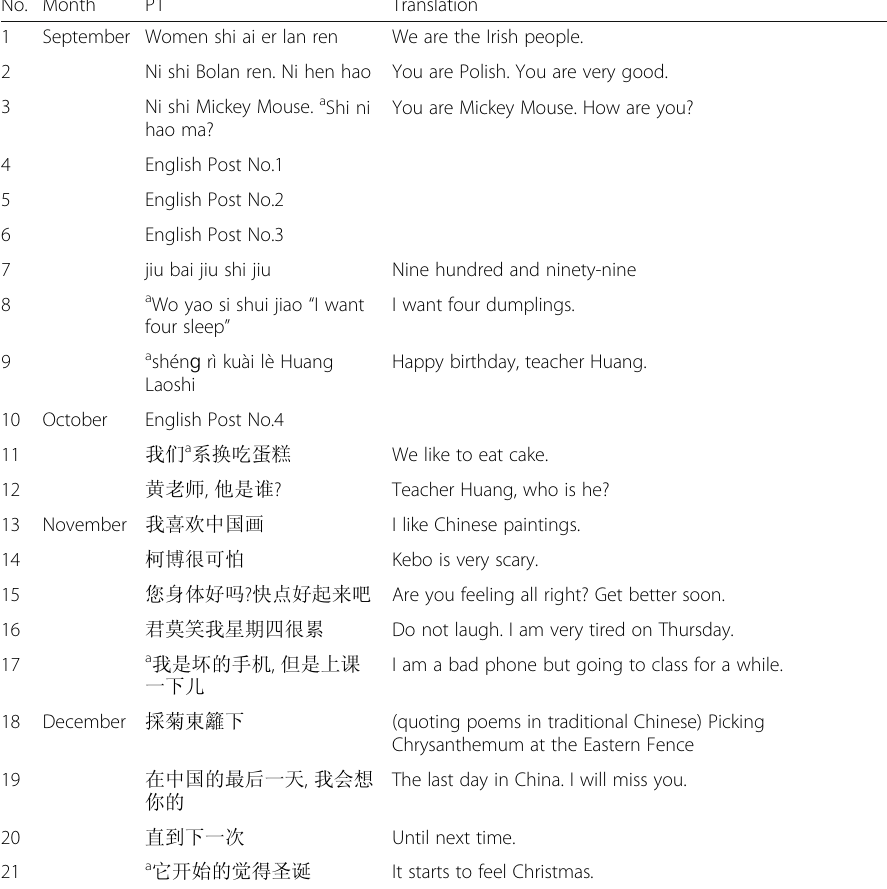
Table 7 The Chinese posts on P1 ’ s WeChat moments No.